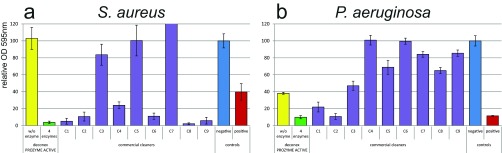
Removal of S. aureus (a) and P. aeruginosa (b) biofilms with different cleaners. Nine commercial cleaners (purple) were compared to deconex Prozyme Active (green) and its corresponding base formulation B3A without enzymes (yellow). The y axis represents the biofilm amount quantified by crystal violet staining relative to the WSH-treated negative control (blue). A mixture of 1% SDS, 1% EDTA, 1% NaOH, and 0.1% NaClO was used as a positive control (red). Error bars represent results from 6 individual replicates.